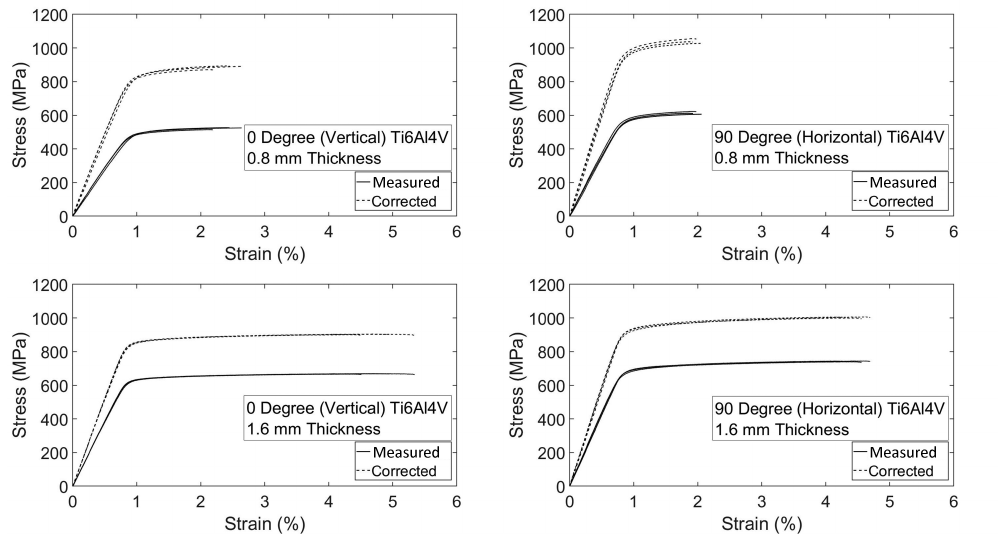
Figure 9. As-built and corrected tensile results for 90 ◦ , 0.8 mm thickness; 0 ◦ , 0.8 mm thickness; 90 ◦ , 1.6 mm thickness; and 0 ◦ , 1.6 mm thickness